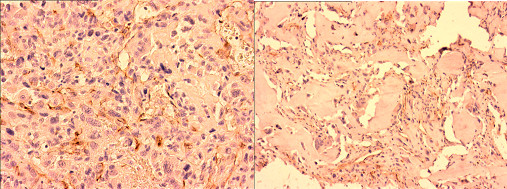
CD31 expression in osteosarcoma before and after chemotherapy. Pre-chemotherapy biopsy (×400) and post-chemotherapy resection specimens (×600) showing immunostaining for CD31.